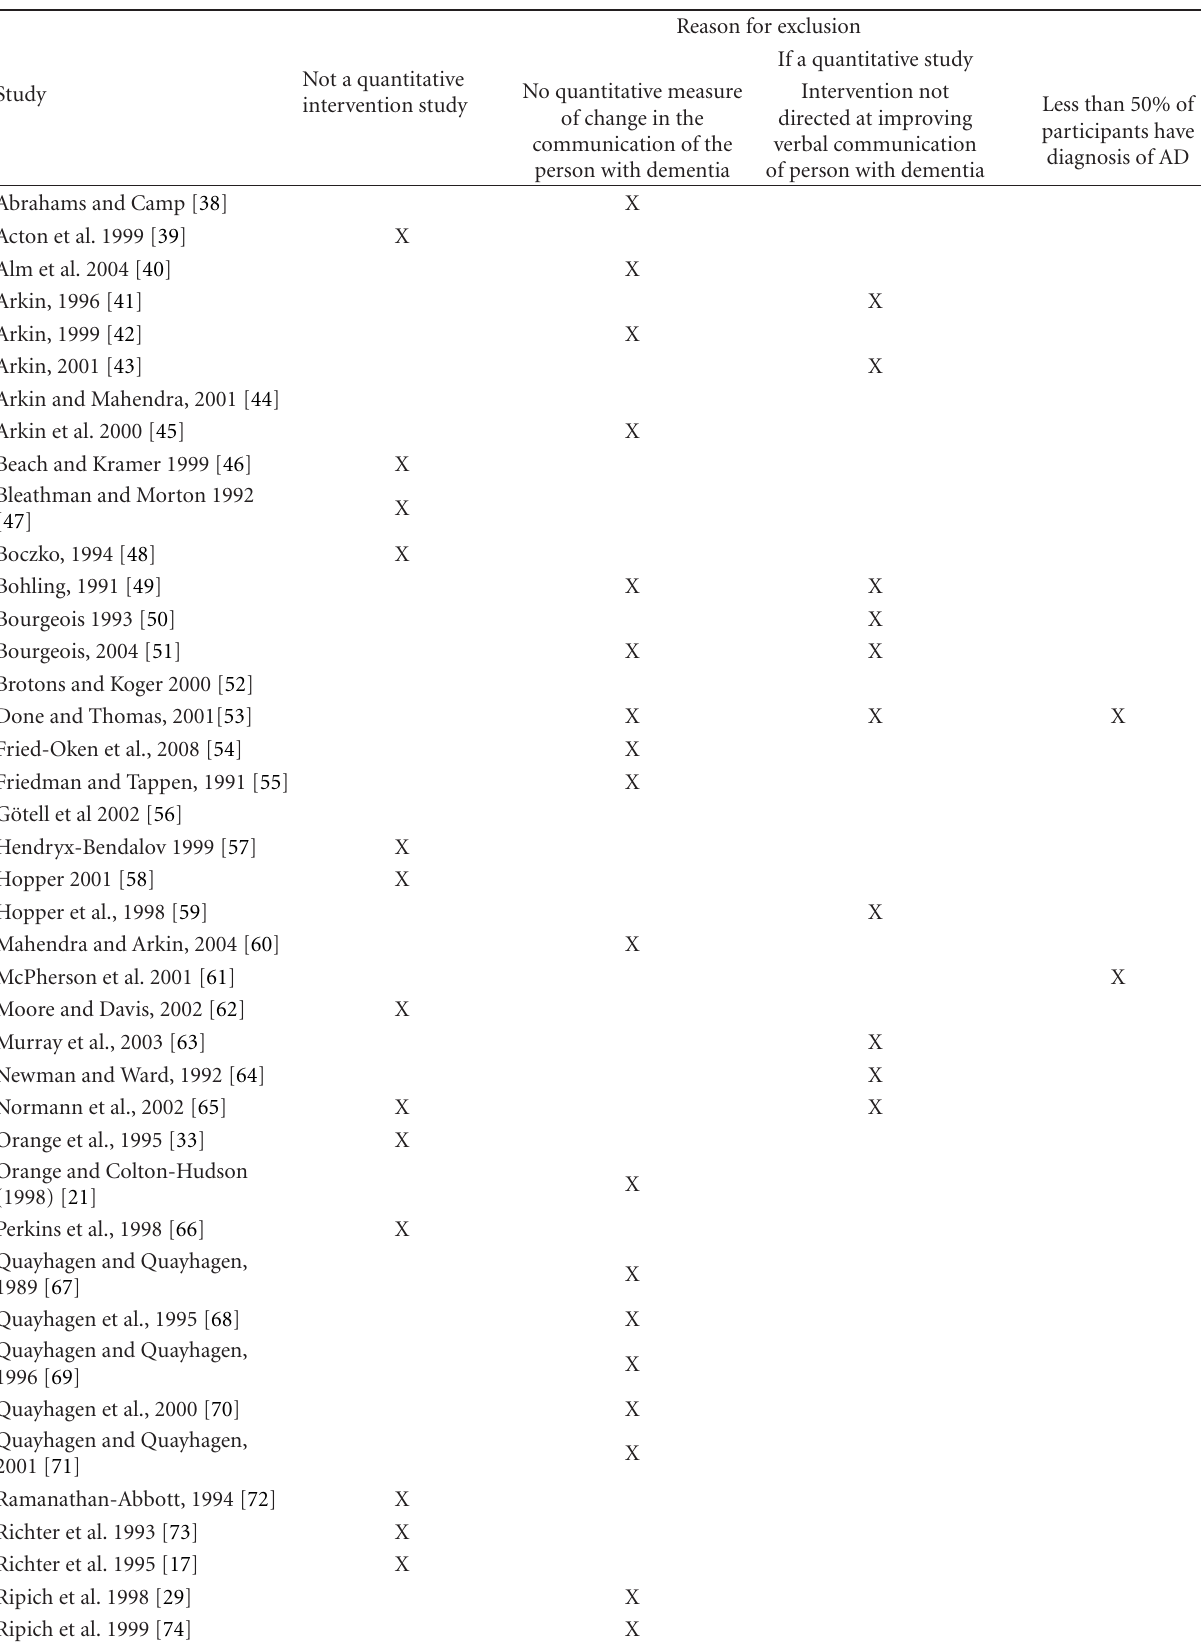
Table 1: Excluded